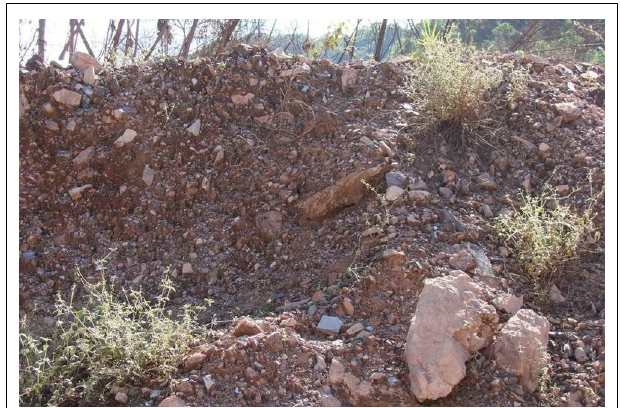
FIGURE 1 | Gomphrena claussenii Moq. plants growing at a Zn mining site atVazante, Minas Gerais,